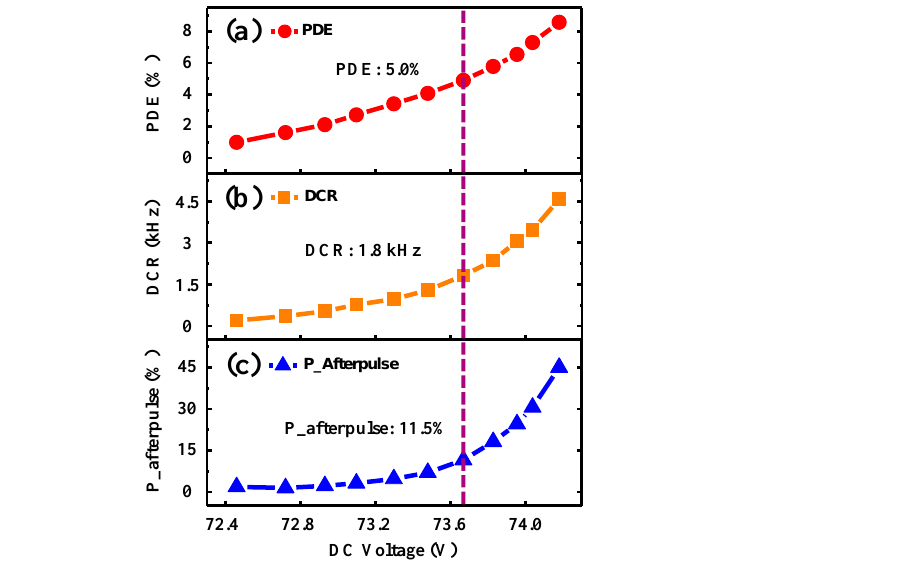
Figure 2. ( a – c ) Photon detection efficiency, dark count rate and probability of afterpulse as a function of DC bias voltage.